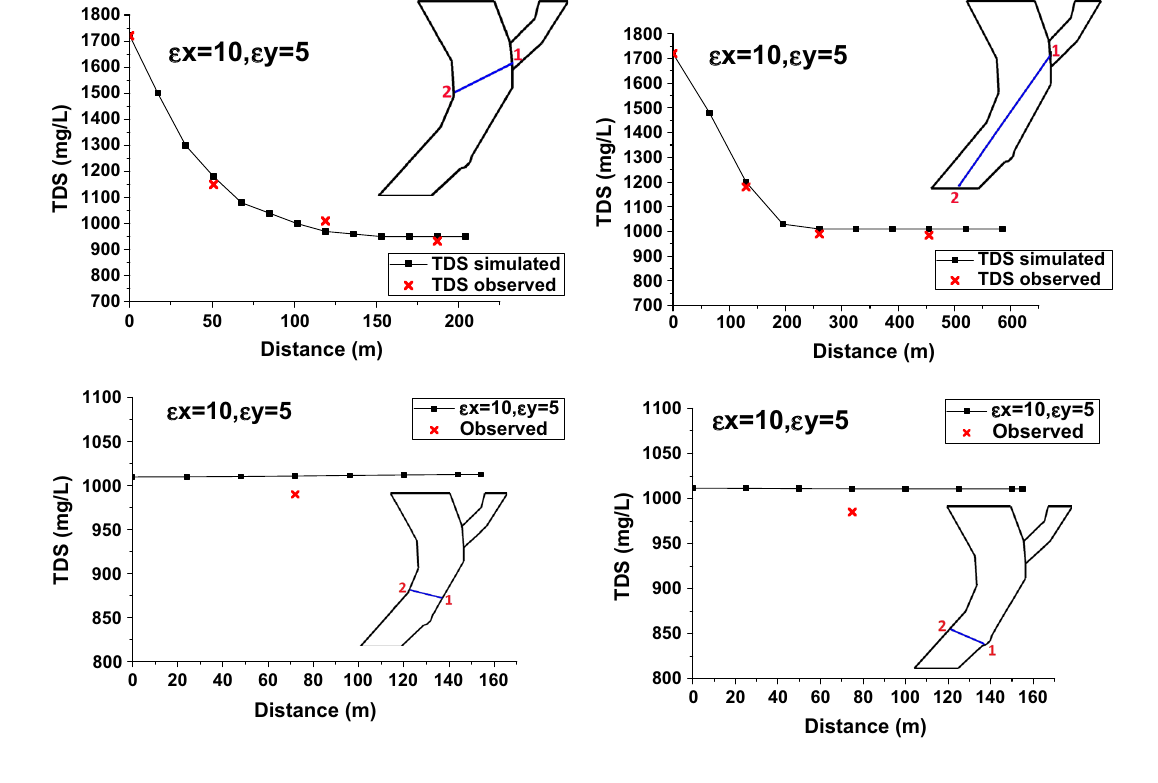
Fig. 5 Validation results of TDS (February